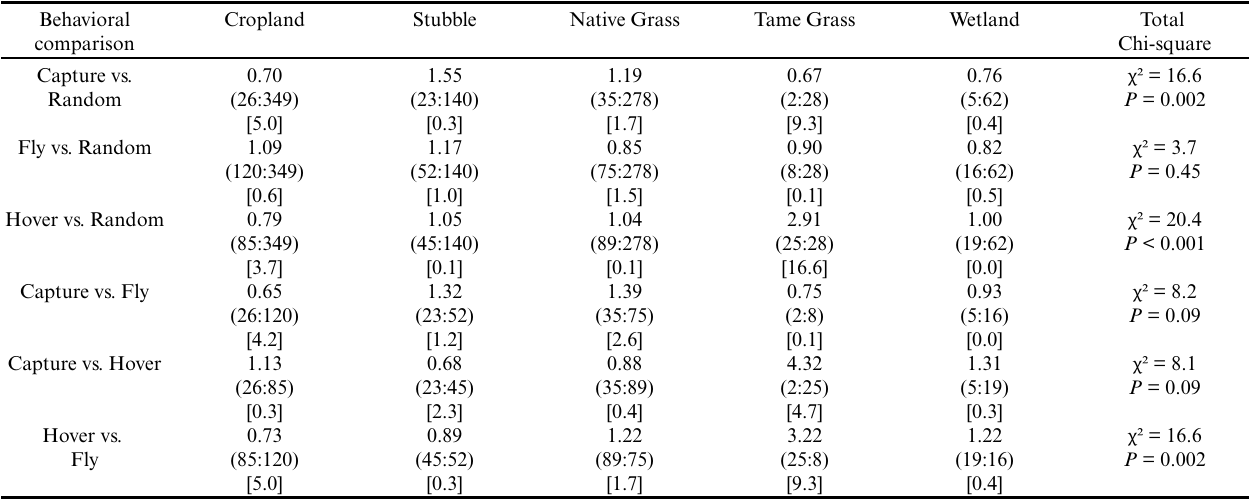
Table 3 . Selection index for various behavioral comparisons within each land-cover class (1 means the proportion of used points is the same as what was available). Results are based on model 2, i.e., land cover not controlling for local vegetation. The second behavior in each comparison is the reference condition. In curved brackets is the ratio of points in each behavior class, e.g., 26 captures versus 349 randoms. In squared brackets is the total cell contribution in χ ² units for that behavioral comparison to the overall chi-square value for that comparison. Larger values have a greater difference in observed than expected.